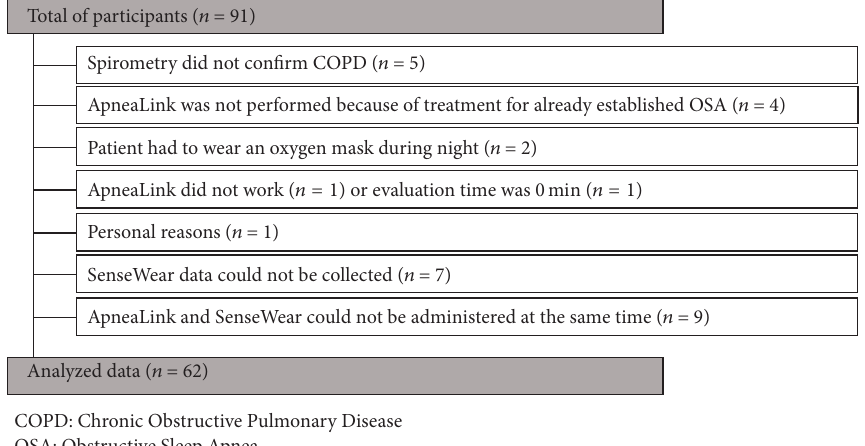
Figure 1: Reasons for exclusion/nonevaluation after